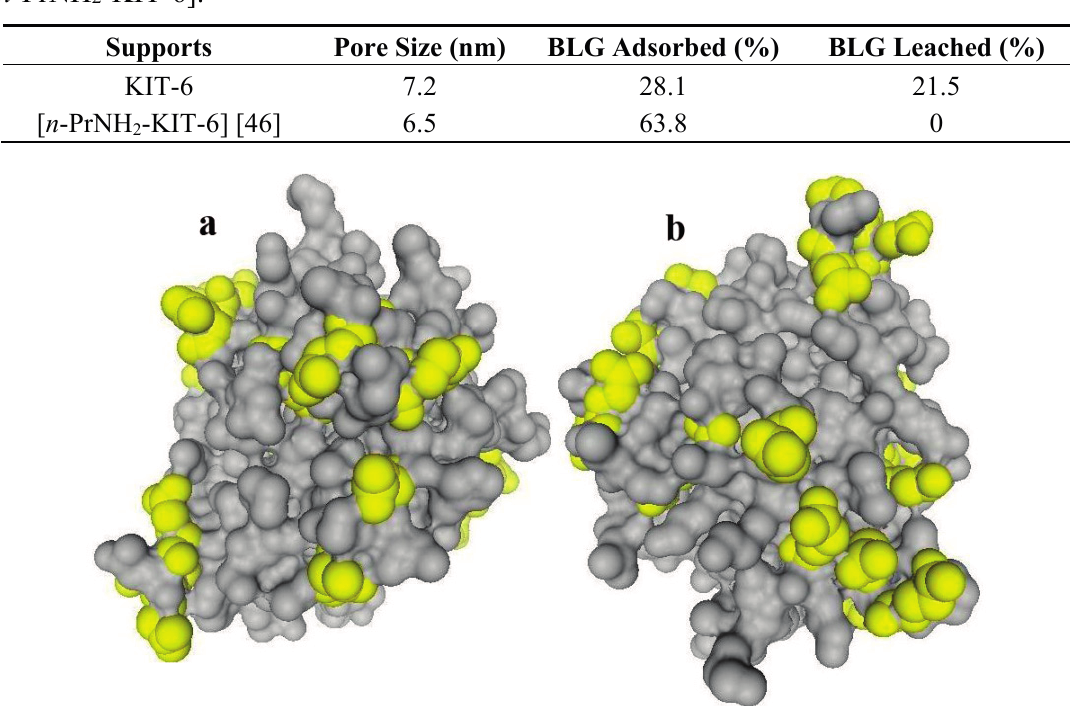
Table 1. The percentage of adsorption and leaching of BLG-B on/from the KIT-6 and [ n -PrNH 2 -KIT-6].